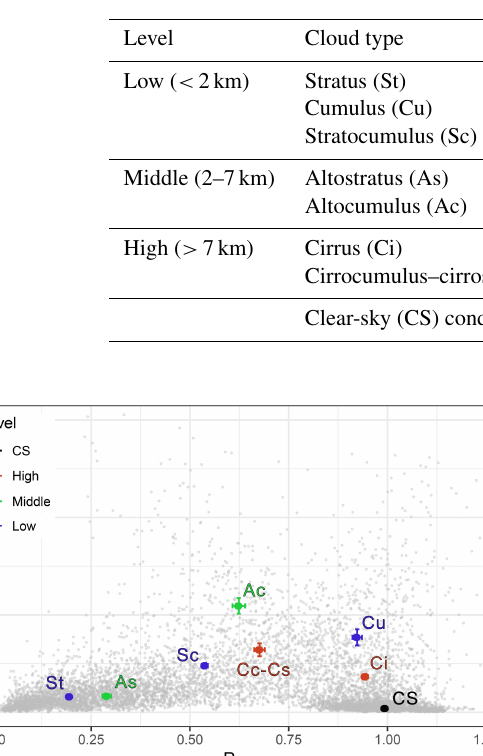
Table 1. Final criteria adopted for cloud classification. SD represents the SD of the measured global irradiance with respect to the theoretical behaviour in clear-sky conditions; R represents the ratio between observed global irradiance ( F glo ) and the modelled irradiance ( F glo_CS ) in clear-sky conditions; and finally the cloud layer is the number of cloud layers detected by the lidar.